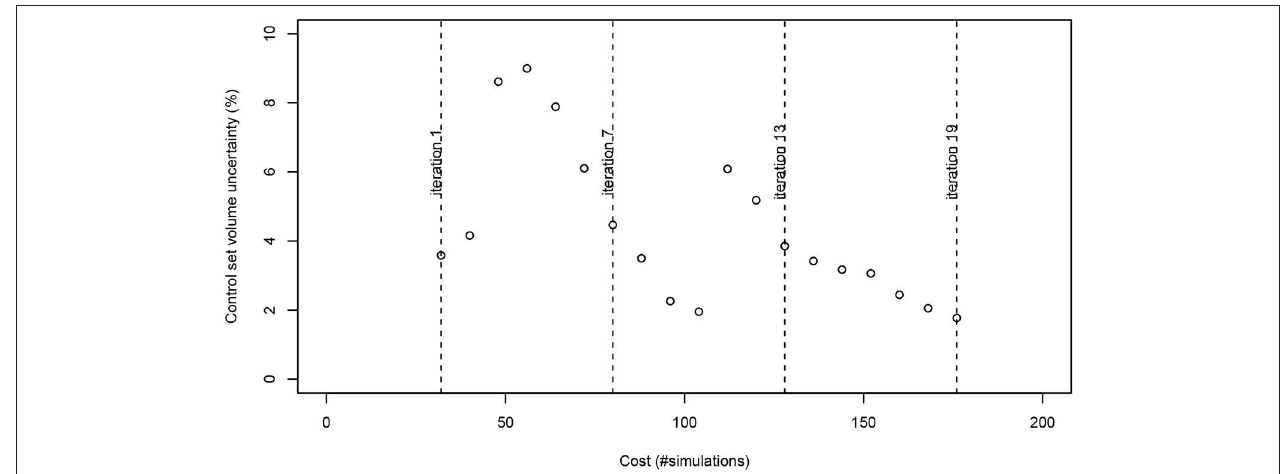
FIGURE 5 | Convergence of RSUR criterion during iterations.